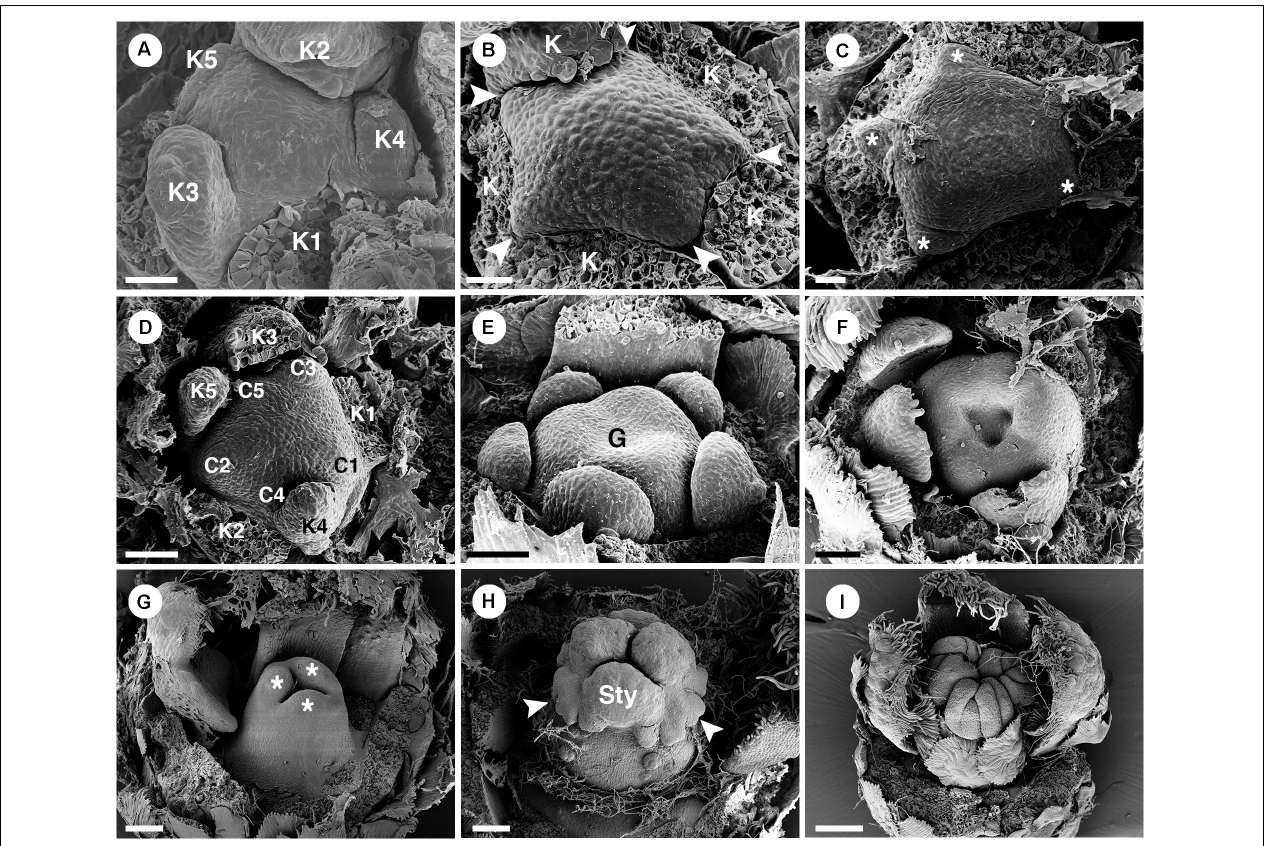
FIGURE 13 | Ontogeny of pistillate flowers of Croton schiedeanus . (A) An early stage of a flower shows unequal sepal lobes on the convex floral primordium. (B) Next, petal primordia start to form alternating with sepals (arrowhead). (C) Apical view of older stage; petals start to expand surrounding the convex receptacle (asterisk). (D) View of a similar stage shows unequal growth of petals. (E) Next, an ovary initiates with three fused carpels. Note, petals continue to grow in a unidirectional pattern. (F) An old flower bud shows expansion of petals and ovary. (G) Stage of ovary closure. The lobe on top of each carpel starts to form a style (asterisk). (H) Three styles are formed on top of the ovary. Note, there are many lobes visible (arrowhead). (I) Later, styles dissected into many parts. K, sepal; C, petal; G, ovary; Sty, style. Scale bars: (A–C) = 20 µ m; (D–F) = 5 0 µ m; (G) = 90 µ m; (H) = 100 µ m; (I) = 150 µ